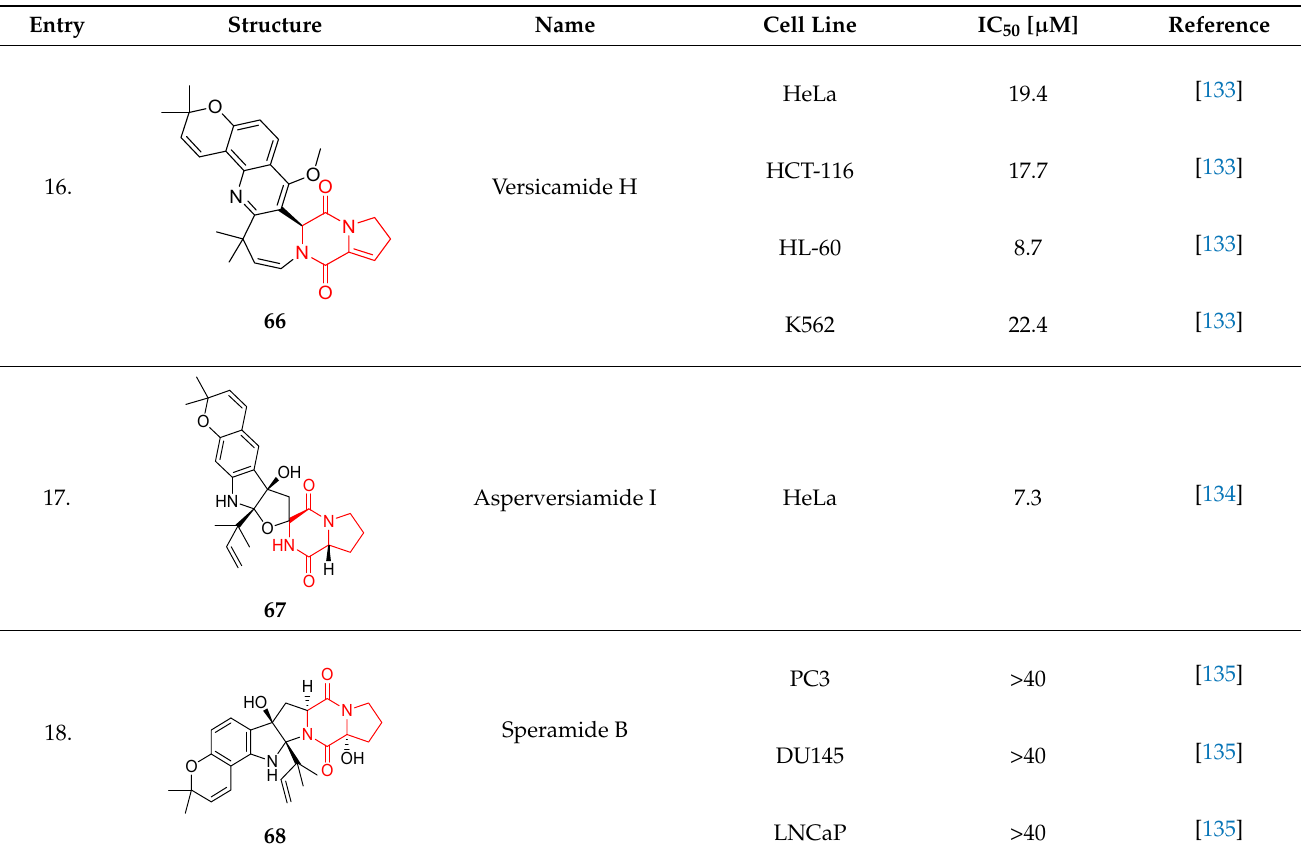
n.a.—non active. Cyclotryprostatin B ( 55 ), Cyclotryptostatin F ( 56 ), and Cyclotryptostatin G ( 57 ) were isolated from Penicillium brasilianum together with Spirotryprostatins 53 , 54 (Table 4, entries 1–3) [131]. These compunds exhibited relatively selective cytotoxic effect when tested on breast cancer cell line MCF ‐ 7, with IC 50 values of 5.1, 7.6, and 10.8 μ M, respectively. In contrary to Cyclotryprostatins B,F and G ( 55 – 57 ), Cyclotryprostatin E ( 58 ), isolated from Aspergillus sydowii SCSIO 00305 [132] did not show any cytotoxic effect when tested on A549, A375 (human melanoma) and HeLa cell lines (Table 4, entry 8), which may indicate that the presence of the prenyl group in the structure of the compound is necessary for the appearance of cytotoxic activity. Pentacyclic Versicamide G ( 59 ), bearing 11 ‐ membered lactam ring, was isolated from marine ‐ derived fungus Aspergillus versicolor , but was not active against HeLa, HCT ‐ 116, HL ‐ 60 and K562 cell lines (Table 4, entry 9) [133]. Together with Versicamide G ( 59 ), six new hexacyclic Versicamides A ‐ F ( 60 – 65 ) (Table 4, entries 10–15) were isolated and tested for cytotoxicity against HeLa, HCT ‐ 116, HL ‐ 60 and K562 but significant effect was not observed. Versicamide G ( 59 ) was further treated with methyl iodide, in the presence of sodium carbonate in tetrahydrofurane, which led to the formation of Versicamide H ( 66 ) (Table 4, entry 16). In contrary to Versicamides A ‐ G ( 59–65 ), compound 66 surprisingly exhibited moderate cytotoxic effect with IC 50 [ μ M] values of 19.4 (HeLa), 17.7 (HCT ‐ 116), 8.7 (HL ‐ 60) and 22.4 (K562). When tested on the panel of 18 selected protein kinases, Versicamide H ( 66 ) showed effective activity on c ‐ Kit (a transmembrane protein that functions as a tyrosine kinase receptor) yielding an inhibitory rate of 60% at a final concentration of 10 μ M [133]. In 2019, Li reported isolation an identification of novel hexacylic asperversiamides I − P from a soil ‐ derived fungus Aspergillus versicolor [134], and observed that one compound, Asperversiamide I ( 67 ), exhibited marked cytotoxic activity against HeLa cell line with